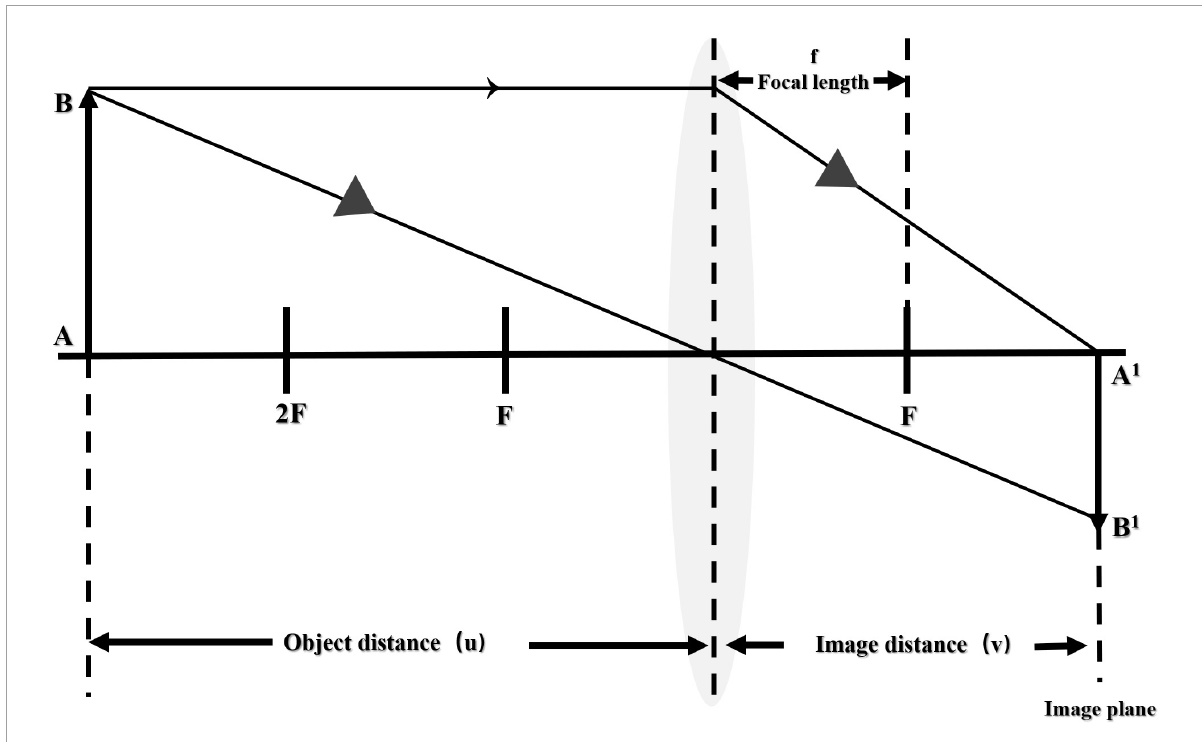
FIGURE4 Area measured by convex lens imaging principle.